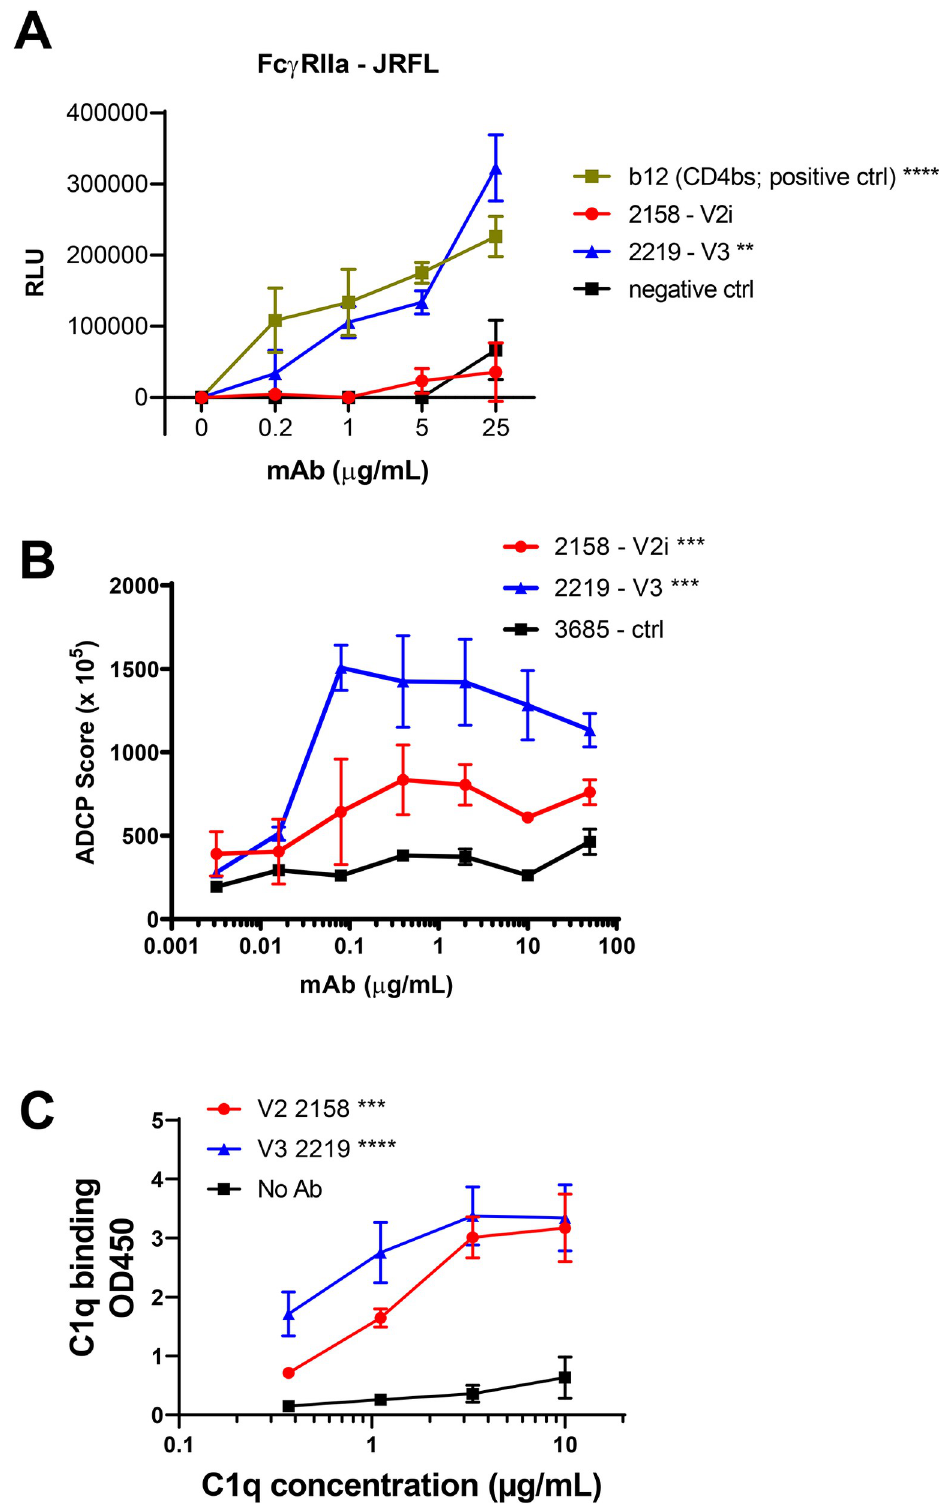
Fig 4. Fc γ RIIa signaling, ADCP, and complement binding activities of V2i mAb 2158 vs V3 mAb 2219. A) Fc γ RIIA signaling was measured by co-incubating JRFL Δ vpu-nucleofected Jurkat cells with Jur- γ RIIa luciferase reporter cells in the presence of V2i, V3, or control mAbs. CD4-binding site mAb b12 served as a positive control.